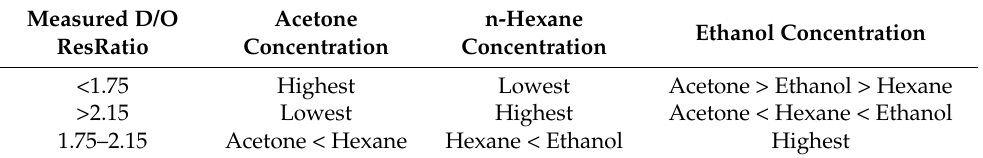
Table 5. Modelling logic for determining the composition of VOCs based on a measured D/O ResRatio.